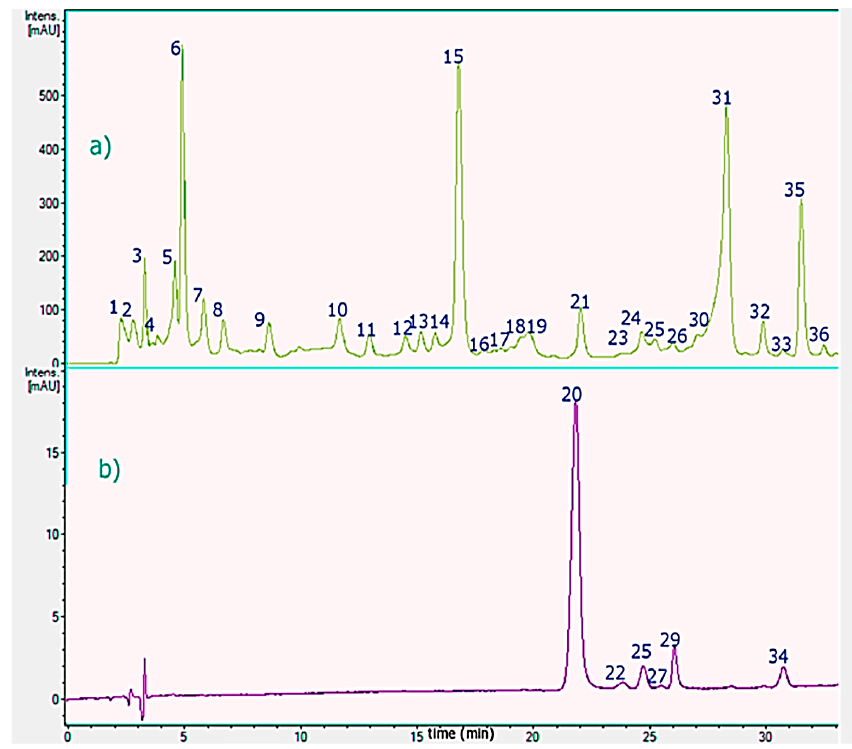
Figure 2. HPLC-PDA chromatograms of T. tetrandus from the VIII region of Chile. ( a ) leaves, monitored